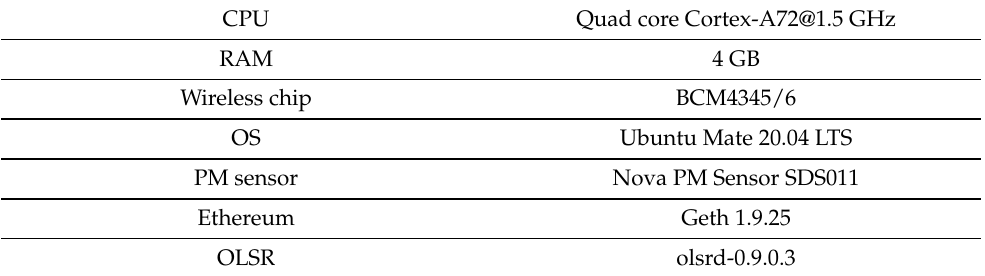
Figure 2. Evaluation topology. Table 3. RPi4